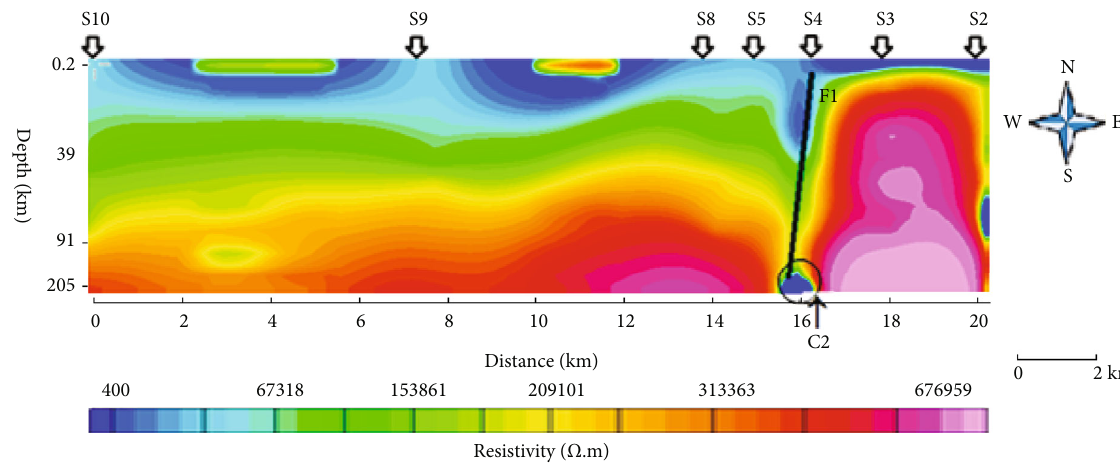
Figure 5: 2D resistivity section of pro fi le